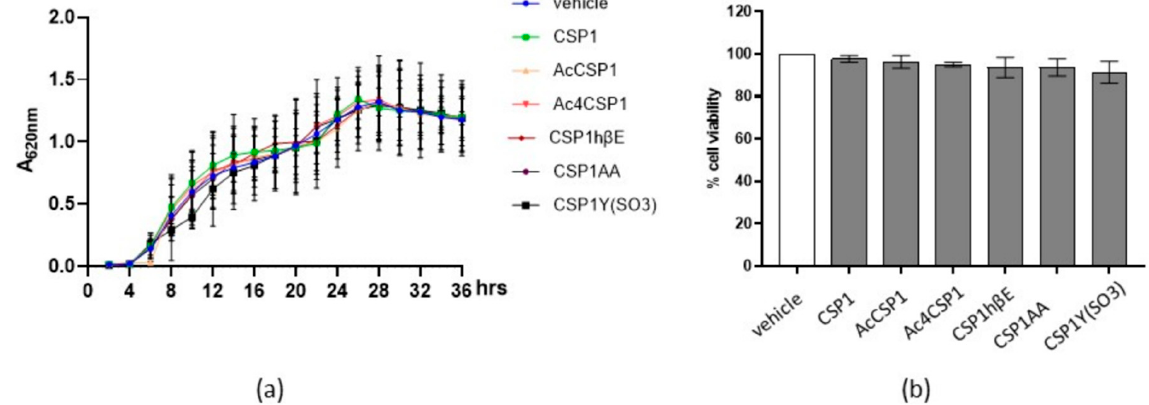
Figure 1. Effects of peptides on prokaryotic and eukaryotic cell growth and viability. ( a ) Cultures of S. mutans (1 × 10 6 CFU/mL) were incubated with 20 µ M of peptides or the vehicle. Bacterial growth was monitored for 36 h by measuring the absorbance at 620 nm (A620 nm). Experiments were performed three times. Data are reported as the mean ± SEM. ( b ) Human primary gingival fibroblasts (HGFs) were cultured with 20 µ M peptides for 24 h. Cell viability was assessed by an MTT assay. Experiments were performed two times. Data are reported as the percentage of cell viability calculated over the control